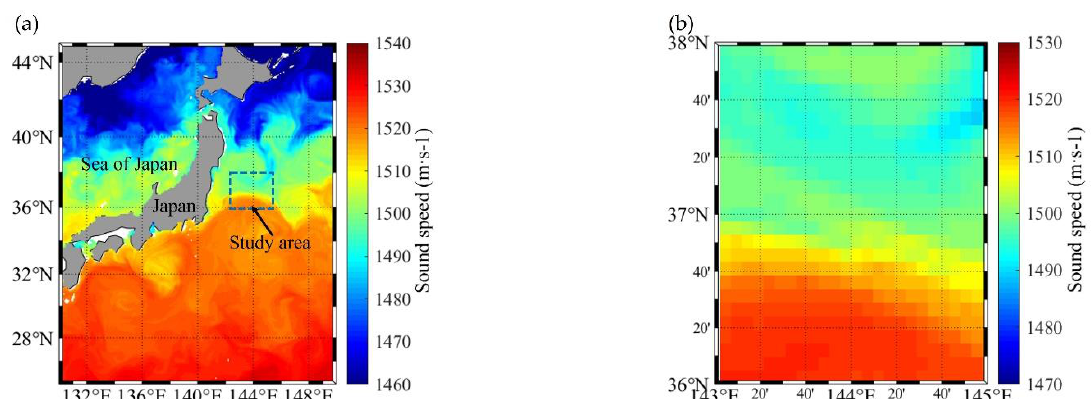
Figure 1. ( a ) The surface sound speed of parts of the Northwest Pacific and the location of the study area; ( b ) The sea surface sound speed distribution of the study area on 1 January 2019. The KEF divides the sea area into three water masses, namely, the low temperature and low salinity water mass in the north of the frontal zone, the high temperature and high salinity water mass in the south of the frontal zone, and the frontal transitional water mass between them.